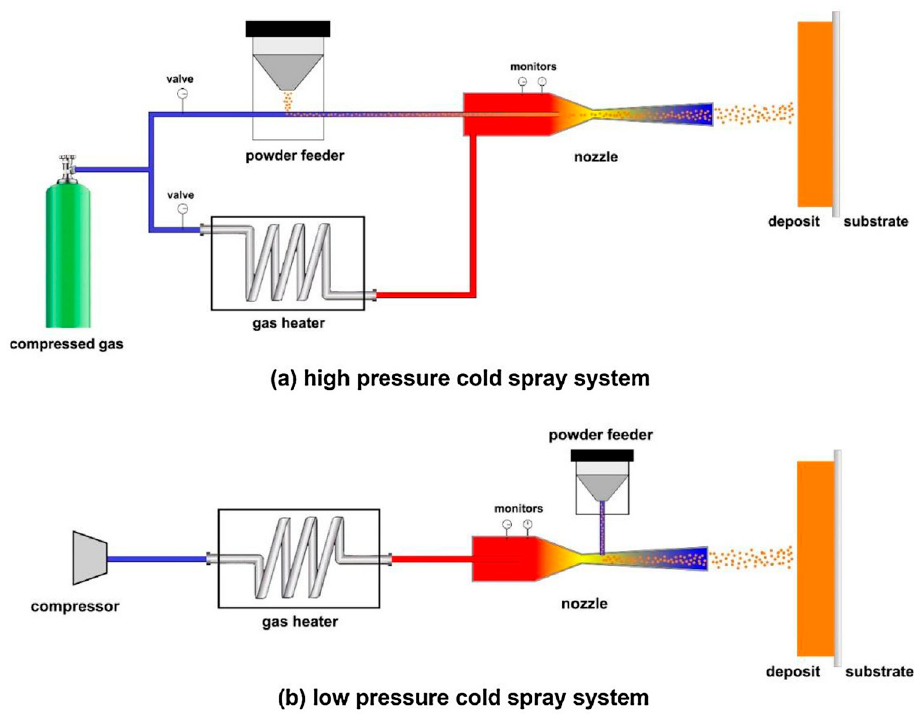
Figure 4. LPCS and HPCS schemes. Reprinted with permission from Ref [2], Elsevier, 2018.